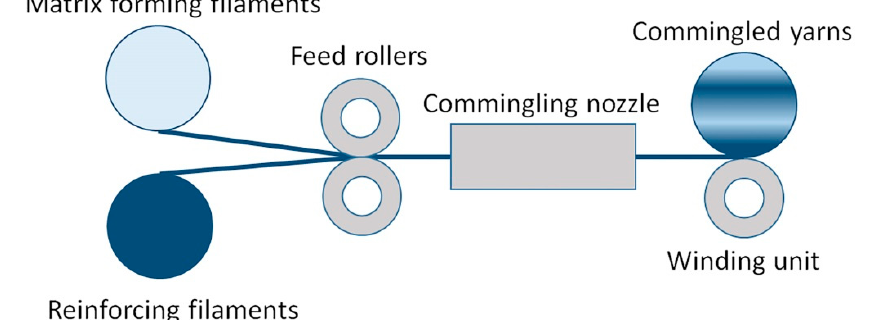
Figure 8. Commingled yarn fabrication.